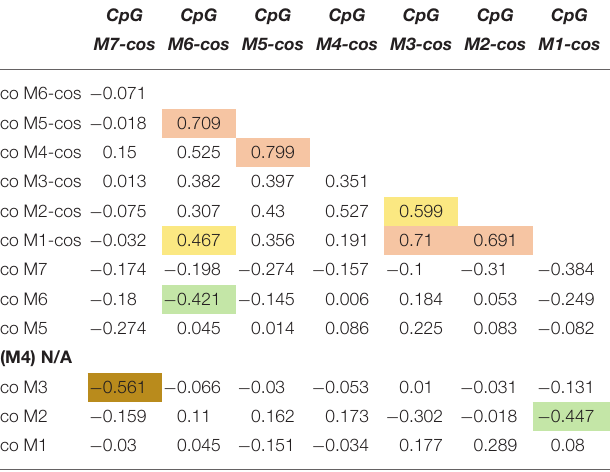
TABLE 1 | Correlation among the newly assessed CpGs and between all the new CpGs vs. all the old CpGs. CpG CpG CpG CpG CpG CpG